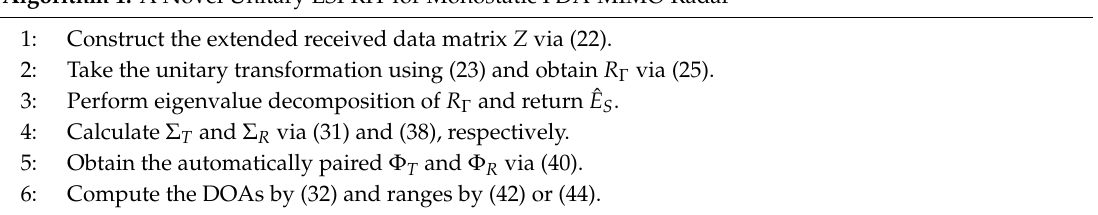
Algorithm 1: A Novel Unitary ESPRIT for Monostatic FDA-MIMO